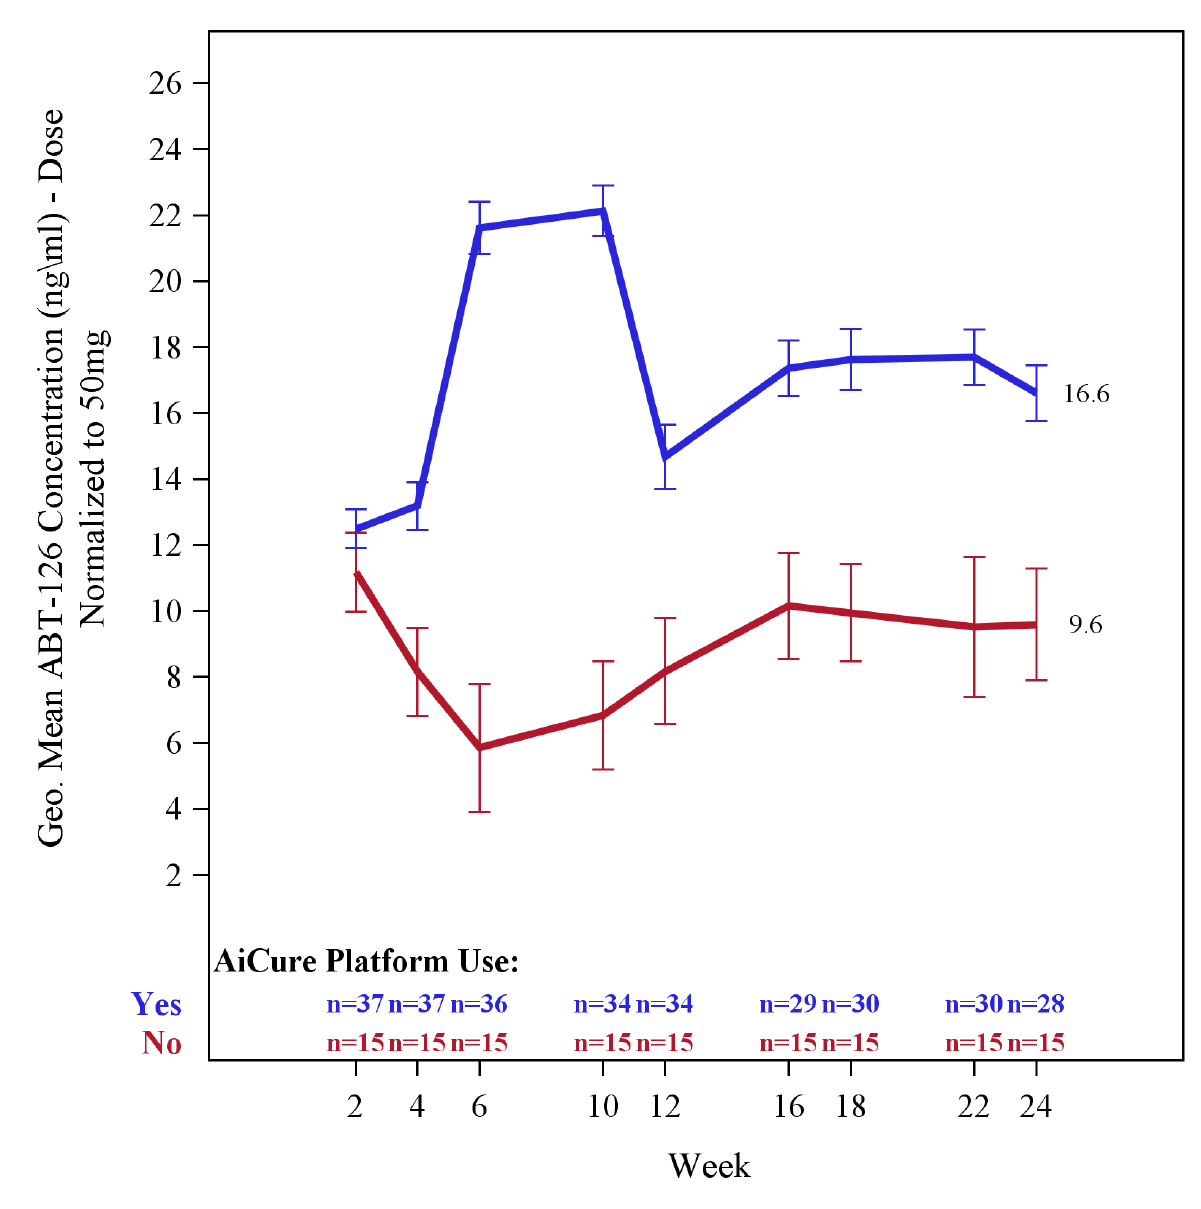
Figure 2. Geometric mean ABT-126 plasma concentrations, normalized to the 50 milligram dose, for subjects who participated in the adherence substudy stratified by artificial intelligence platform versus modified directly observed therapy use. Error bars indicate mean with standard errors. ng/mL: nanograms/milliliter; mg: